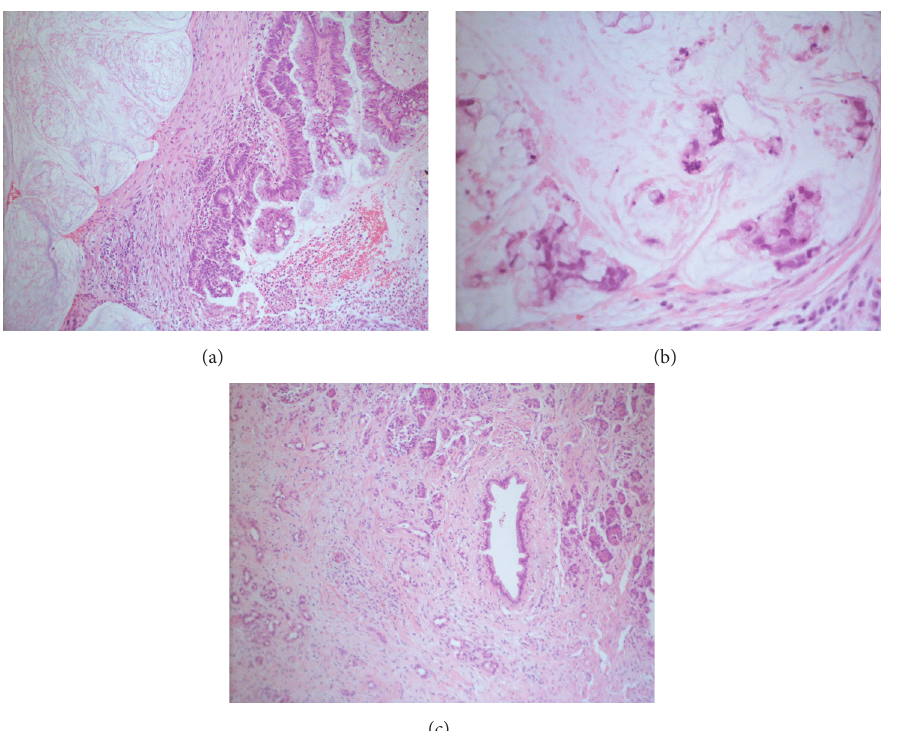
Figure 3: Histologic findings. Hematoxylin-eosin, 100x. (a) Neoplastic epithelium of a pancreatic duct, with formation of papillary structures (ontheright).Abundantmucinformationontheleftside.(b)Mucinousuniformcellswithepithelialatypiaandinvasionoftheneighborhood. (c) Tumor-free pancreatic tissue. Distortion of the normal architecture; moderate-to-severe fibrosis is seen with inflammatory cell infiltration. We can observe dilated ductal elements and atrophy of acinar